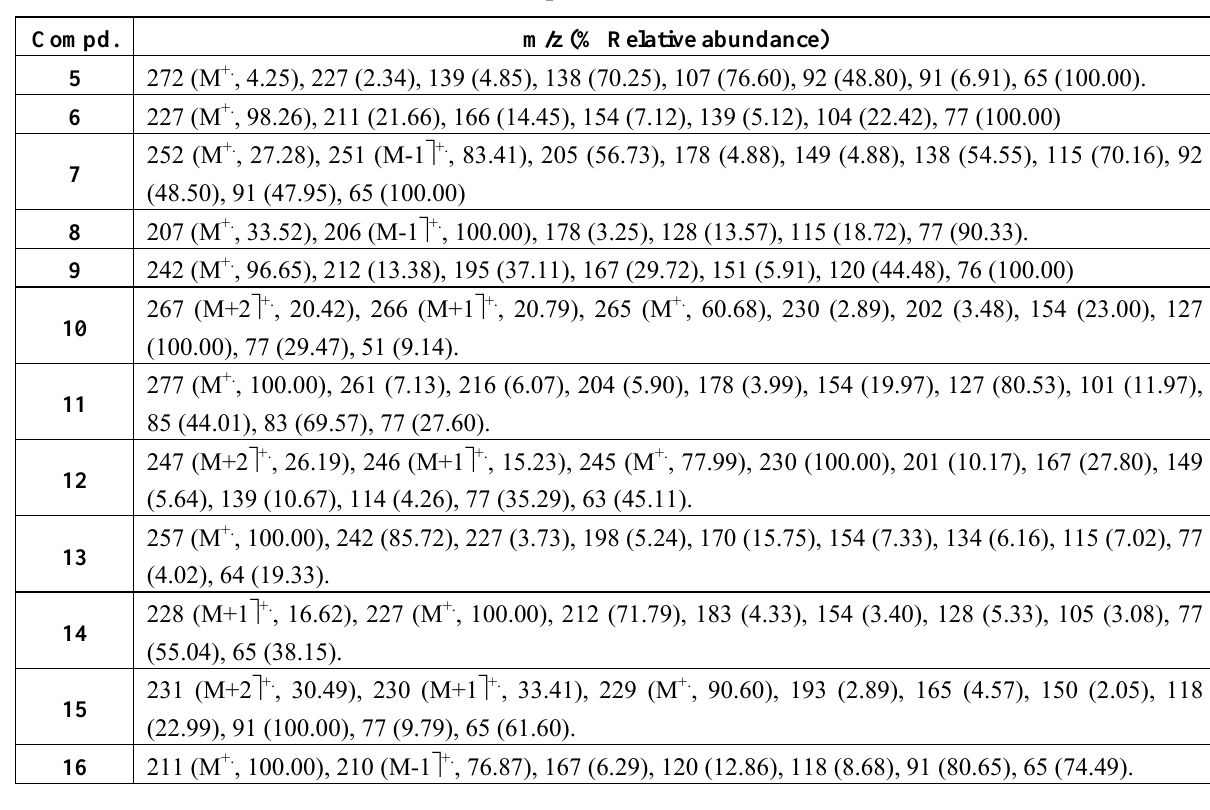
Table 4. Mass spectra of azomethines 5 - 16